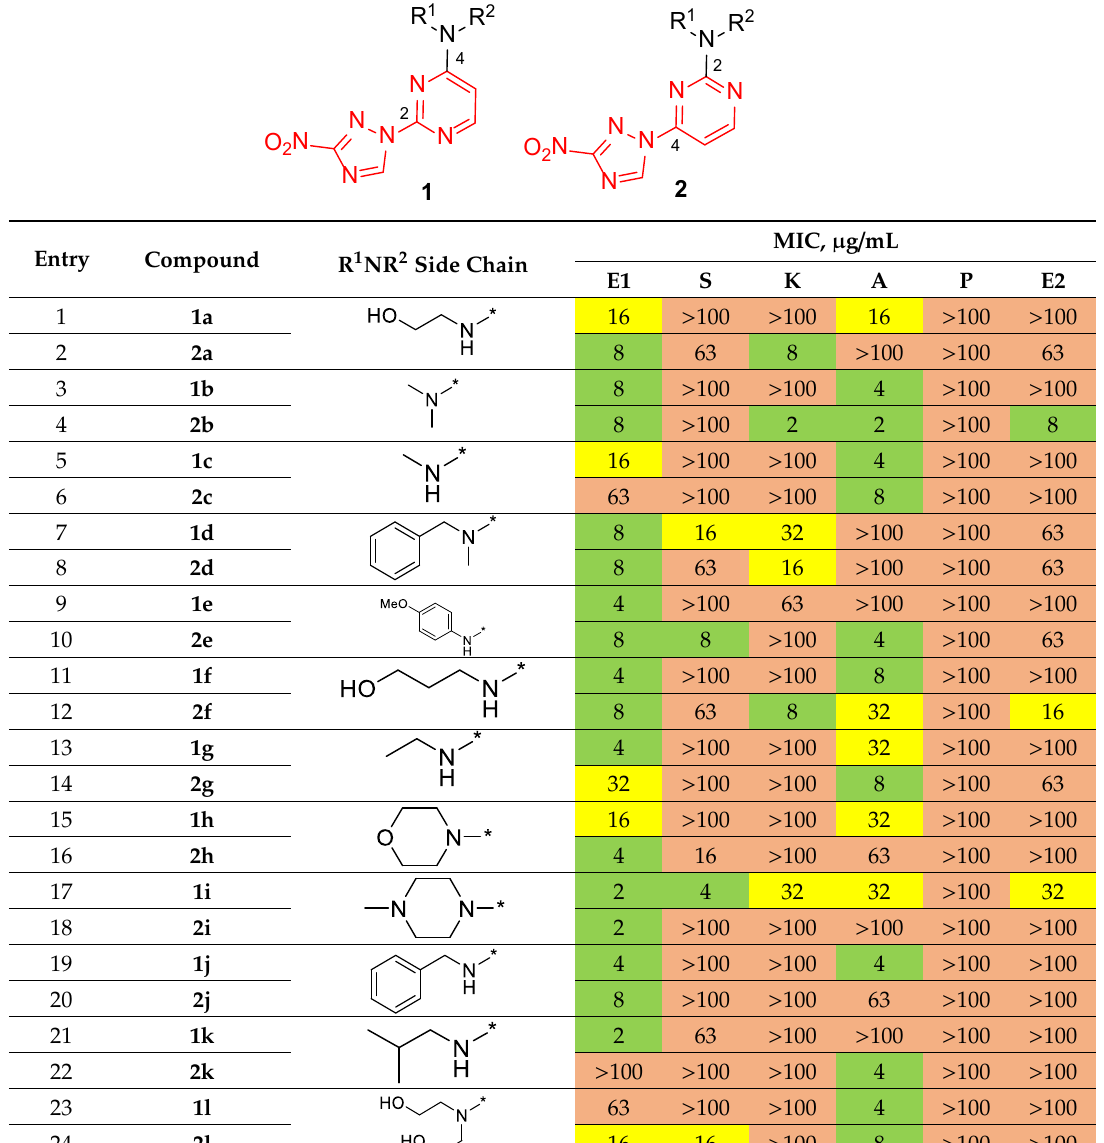
Table 3. Antibacterial activity (minimal inhibitory concentration, MIC) of compounds 1a-s , 2a-s , 4 and ciprofloxacin (positive control) against the ESKAPE panel of pathogens (E1 = Enterococcus faecium (G+), S = Staphylococcus aureus (G+), K = Klebsiella pneumonia (G-), A = Acinetobacter baumannii (G-), P